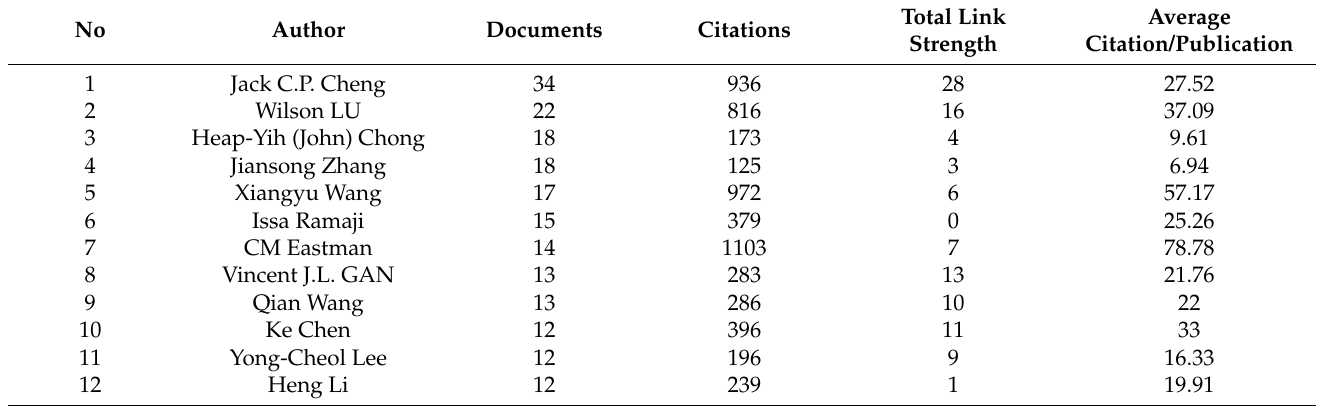
Table 4. Top 20 authors in the field of BIM, IoT, and DT in